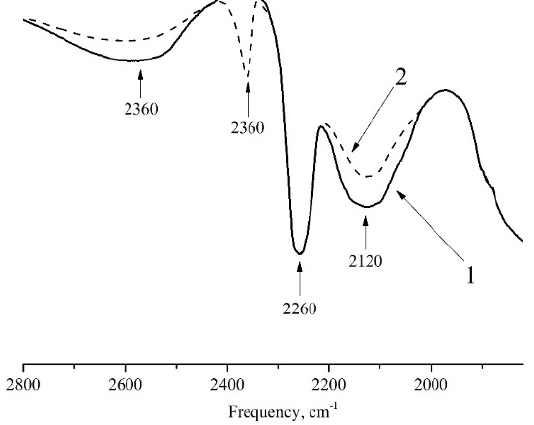
Figure 4. IR spectra of NO adsorbed at 20 ◦ C and 10 Torr on Ca-MOR zeolite (1) followed by adsorption of CO (20 ◦ C, 10 Torr) and heating at 250 ◦ C (2). The reaction of methane oxidation with NO on Ca-mordenite also occurs only at elevated temperatures over 300 ◦ C and results in CO 2 formation. The Mg-MOR, Sr-MOR, and Na-MOR zeolites demonstrate about the same pattern in the reactions NO + CO and NO + CH 4